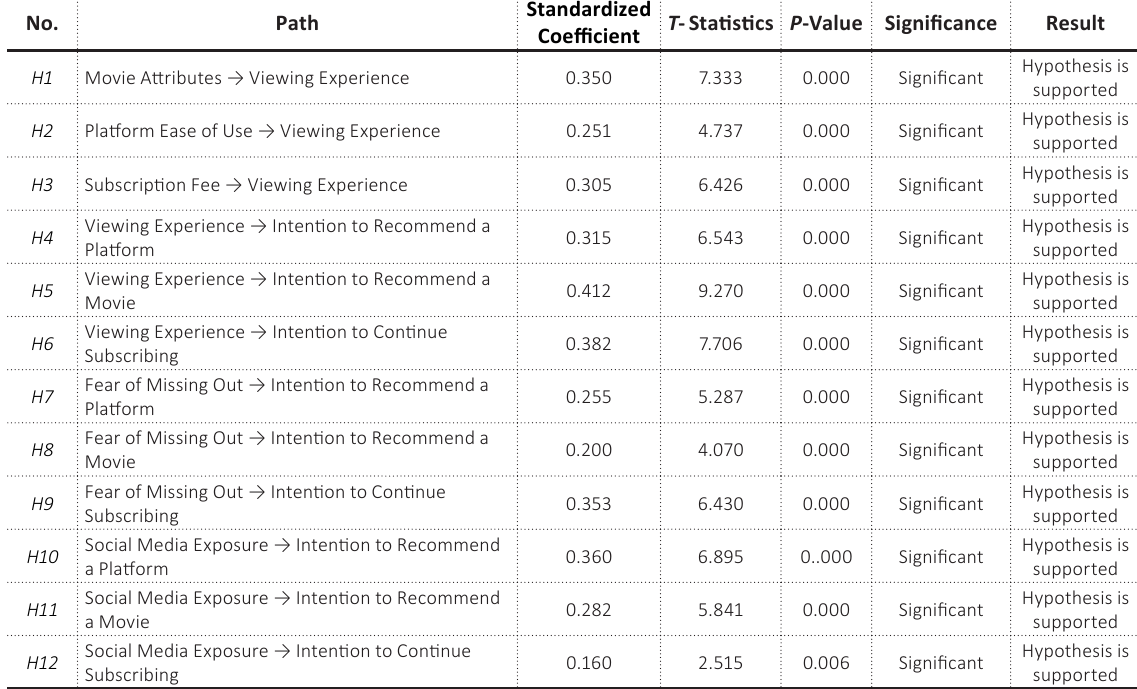
Table 4. Hypotheses testing results